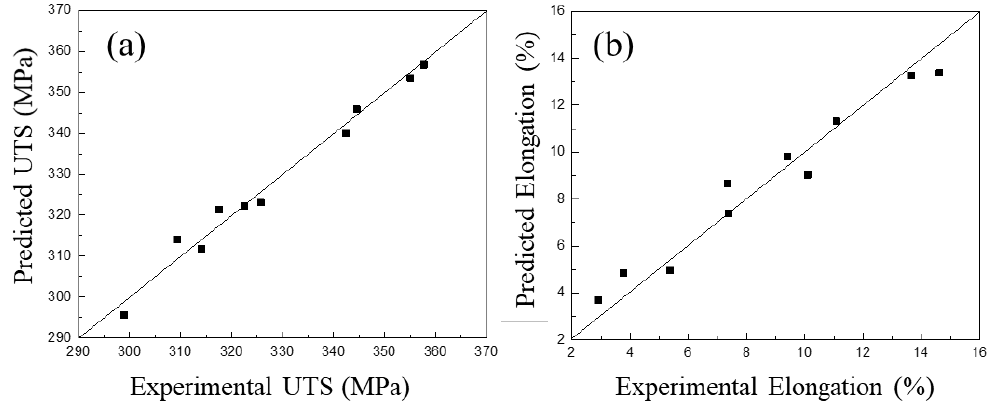
Figure 4. Comparison of the predictions and experiment results for: ( a ) Ultimate tensile strength (UTS) and ( b ) elongation.